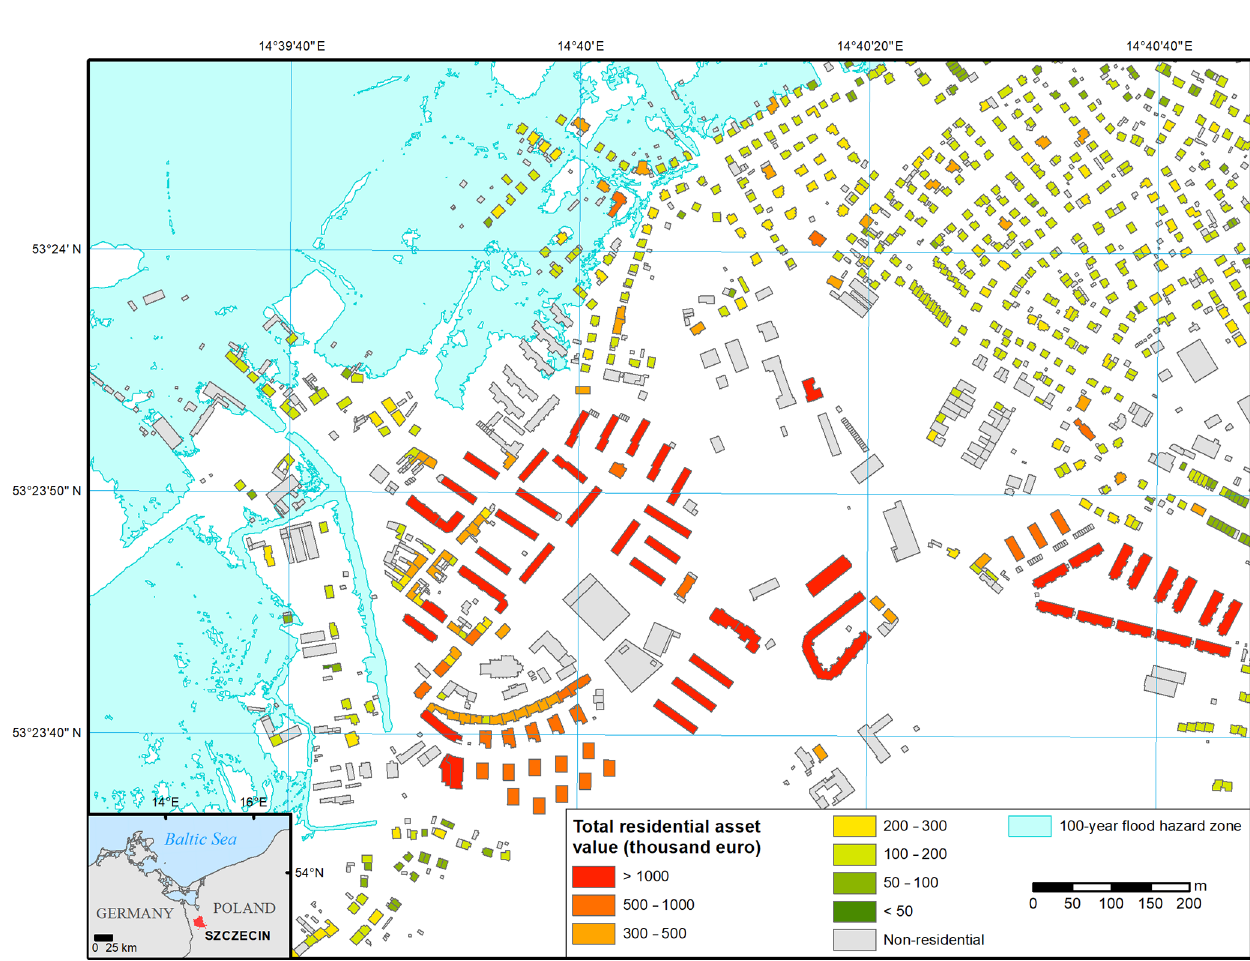
Figure 7. Estimated residential asset values in a low-lying part of the city of Szczecin, Poland. Flood hazard zone from Paprotny and Terefenko (2017). Building geometry from © OpenStreetMap contributors 2019. Distributed under a Creative Commons BY-SA